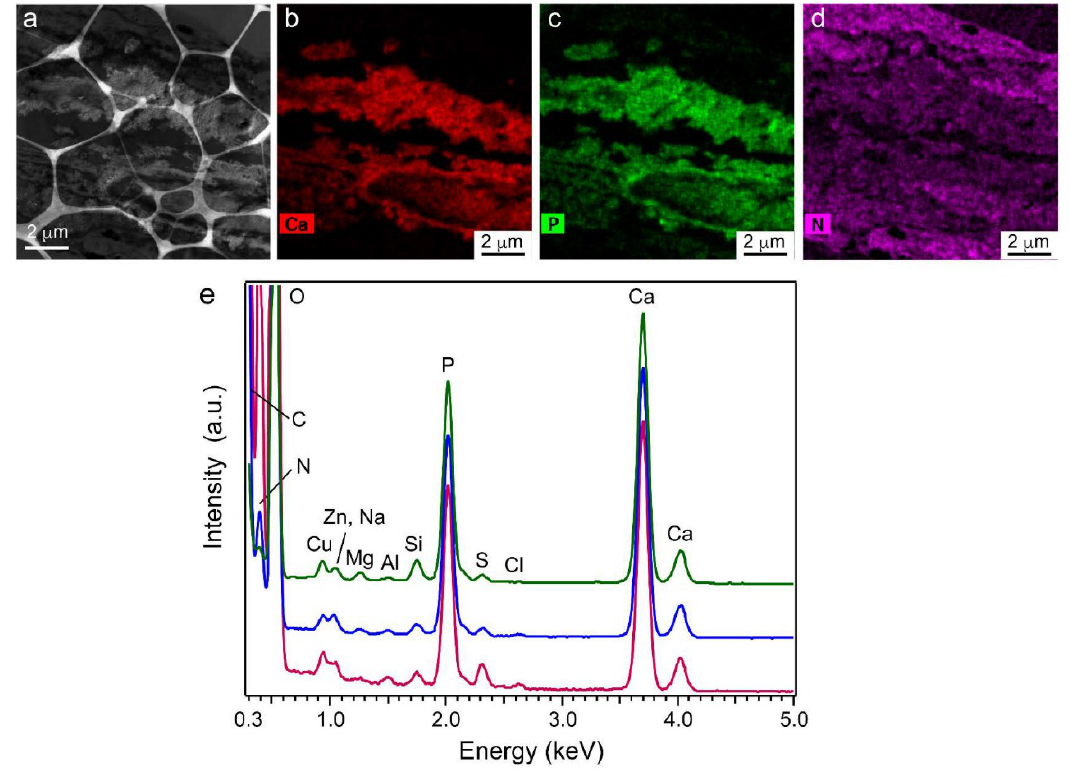
Figure 10. Scanning TEM energy-dispersive X-ray spectroscopy (STEM-EDS) analysis results for precipitates. ( a ) Low-magnification TEM image for energy-dispersive X-ray spectroscopy (EDS) analysis. Two-dimensional elemental mappings of ( b ) Ca, ( c ) P, and ( d ) N. ( e ) STEM-EDS spectra for three measured areas: approximately 12 µ m, 1.5 µ m, and 200 nm (magenta, blue, and green curves, respectively). Cu is attributed to the TEM grid, and Al is equipment specific. Each spectrum was normalized by the intensity of Ca at 3.7 keV.